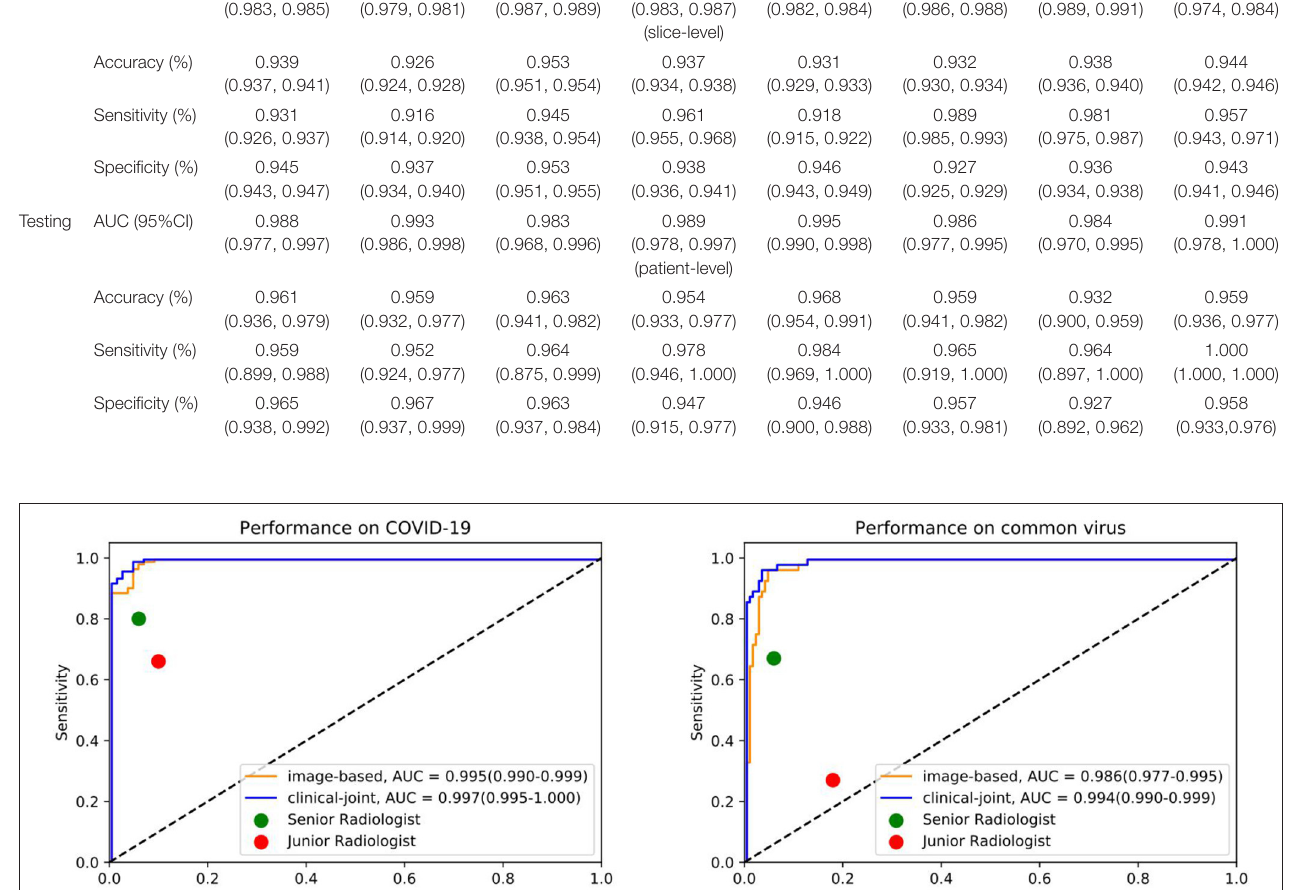
Frontiers in Medicine |